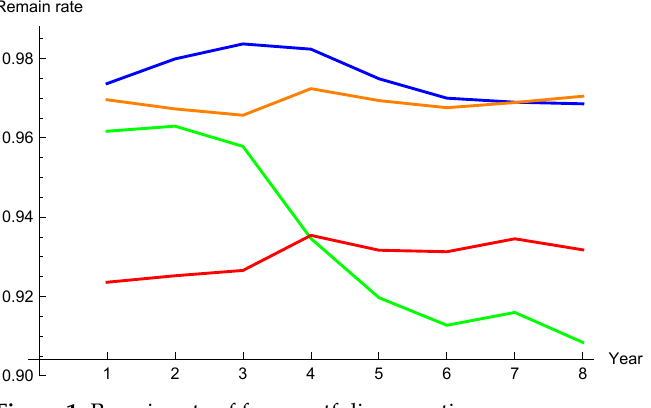
Figure 1. Remain rate of four portfolios over